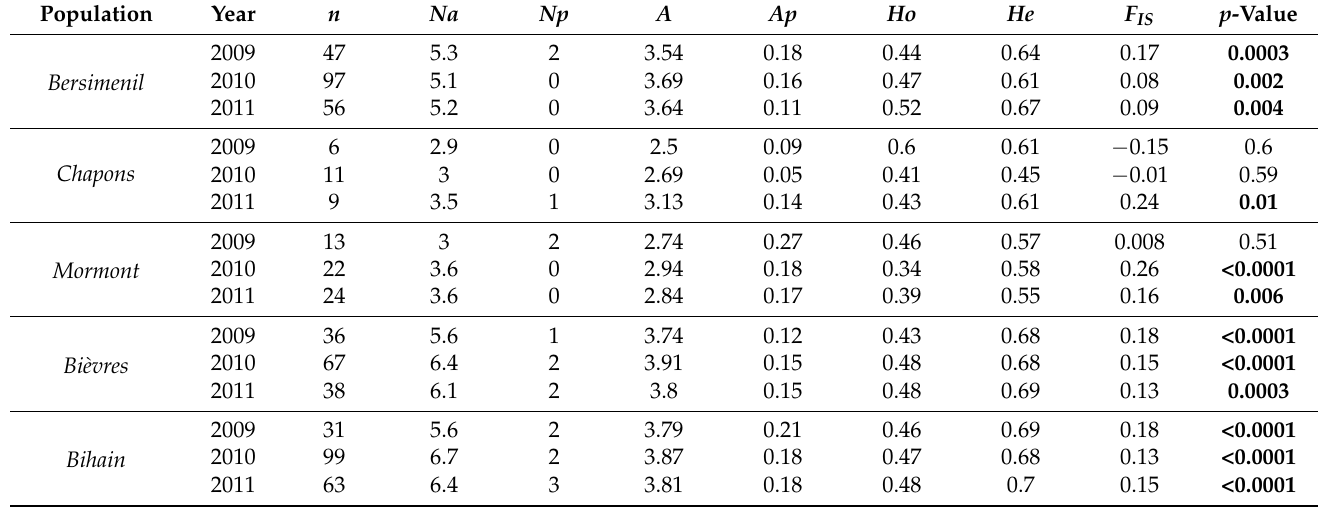
Figure 3. Genetic clustering across the whole metapopulation of Boloria eunomia using the three years of sampling. Bayesian clustering shows two major clusters separating B é rismenil, Chapons and Mormont (light grey) from the other populations (dark grey). Each bar represents the membership assignment to the two clusters of each individual. Within each population, vertical black traits separate the three years of sampling in the same order (2009, 2010 and 2011). A second run of analysis in the two clusters reveals the sub-structuring as indicated at the bottom of the figure. Table 2. Genetic diversity. n = genetic sample size, Na = number of alleles, Np = number of private alleles, A = Allelic richness, Ap = Private allelic richness, Ho = observed heterozygosity, He = expected heterozygosity, significant (< 0.05) p -values for F IS values are in bold in the last